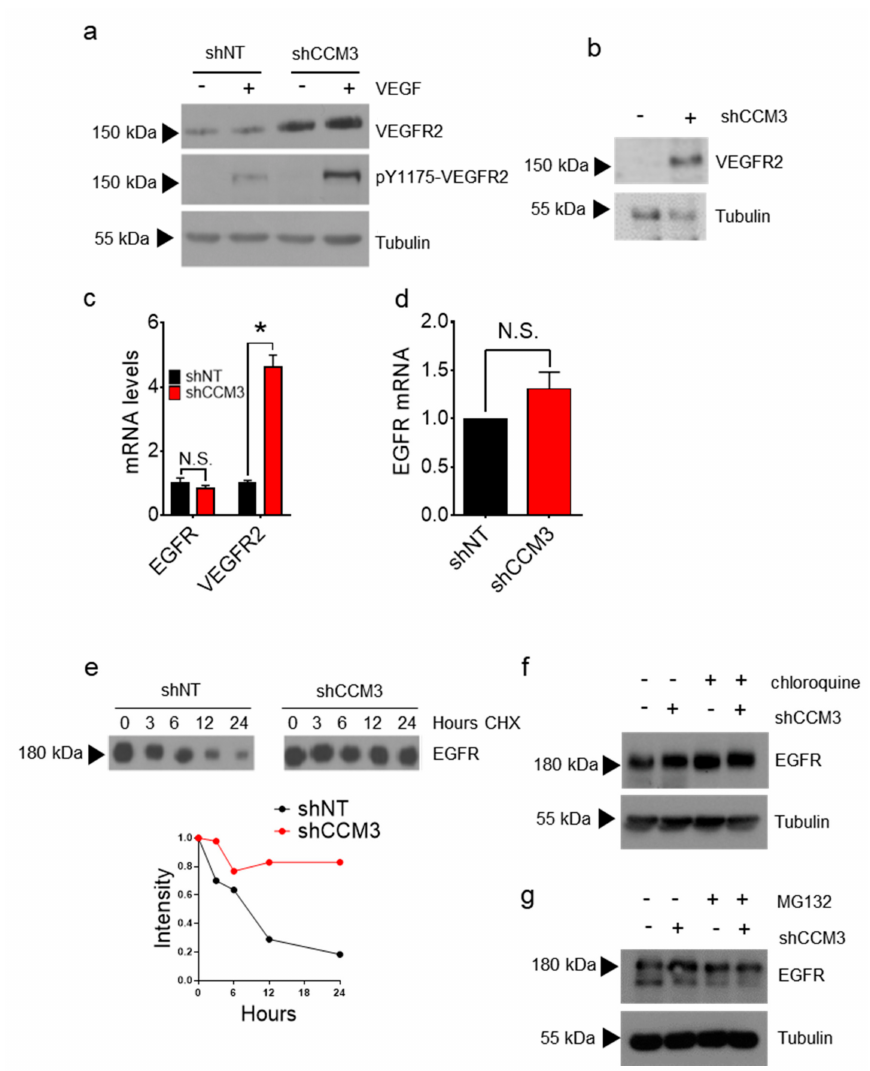
Figure3. UpregulationofEGFfamilyreceptorsinCCM3-deficientcellsispostranscriptional; ( a )VEGFR2 and phosphorylated VEGFR2 (pY1175) in shNT and shCCM3 HuVECs before and after VEGF stimulation; ( b ) Western blot of VEGFR2 in hCMEC / D3 cells; ( c ) mRNA levels of EGFR andVEGFR2 in HuVECs. * p < 0.05; ( d ) mRNA levels of EGFR in A549 cells; ( e ) EGFR in A549 cells transduced cycloheximide. ( f ) EGFR Western blot in shNT and shCCM3 A549 cells treated or not with